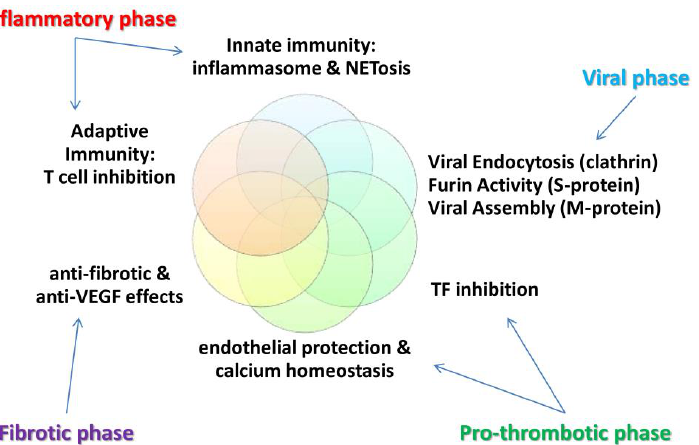
Figure 2. Colchicine’s mechanisms of actions generate the multifaceted hypothesis against COVID- 19